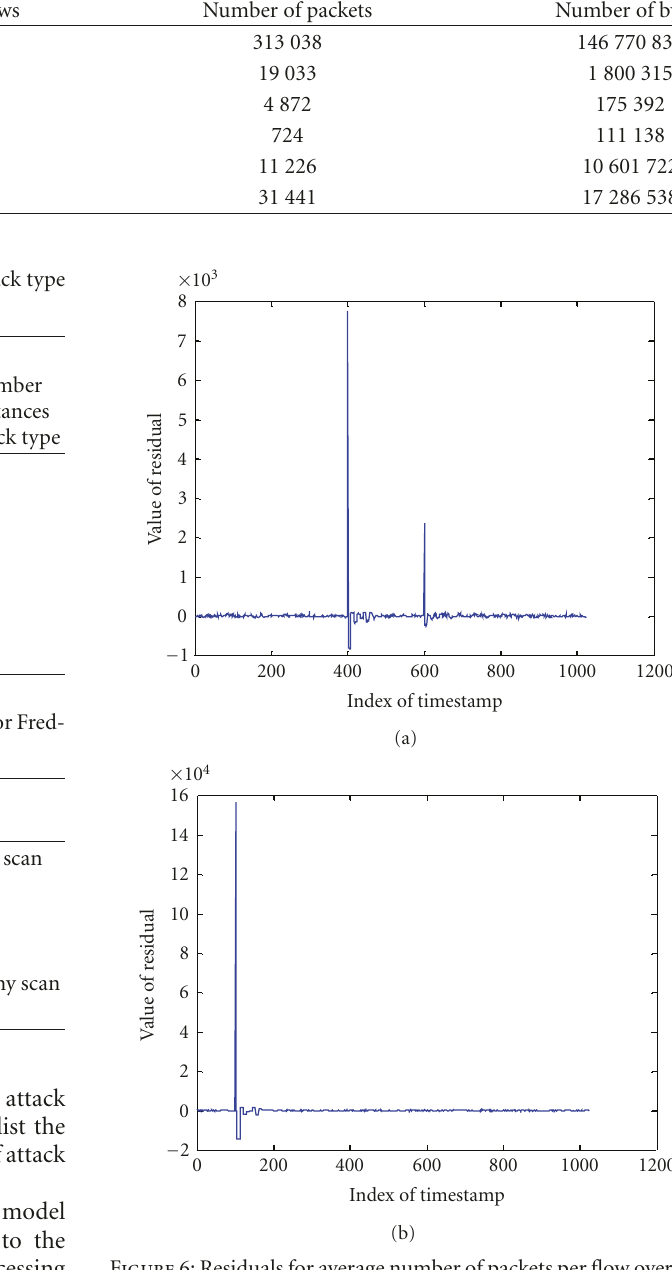
Figure 6: Residuals for average number of packets per flow over one minute; from left to right is Figures 6(a) and 6(b), representing TCP and UDP flows,